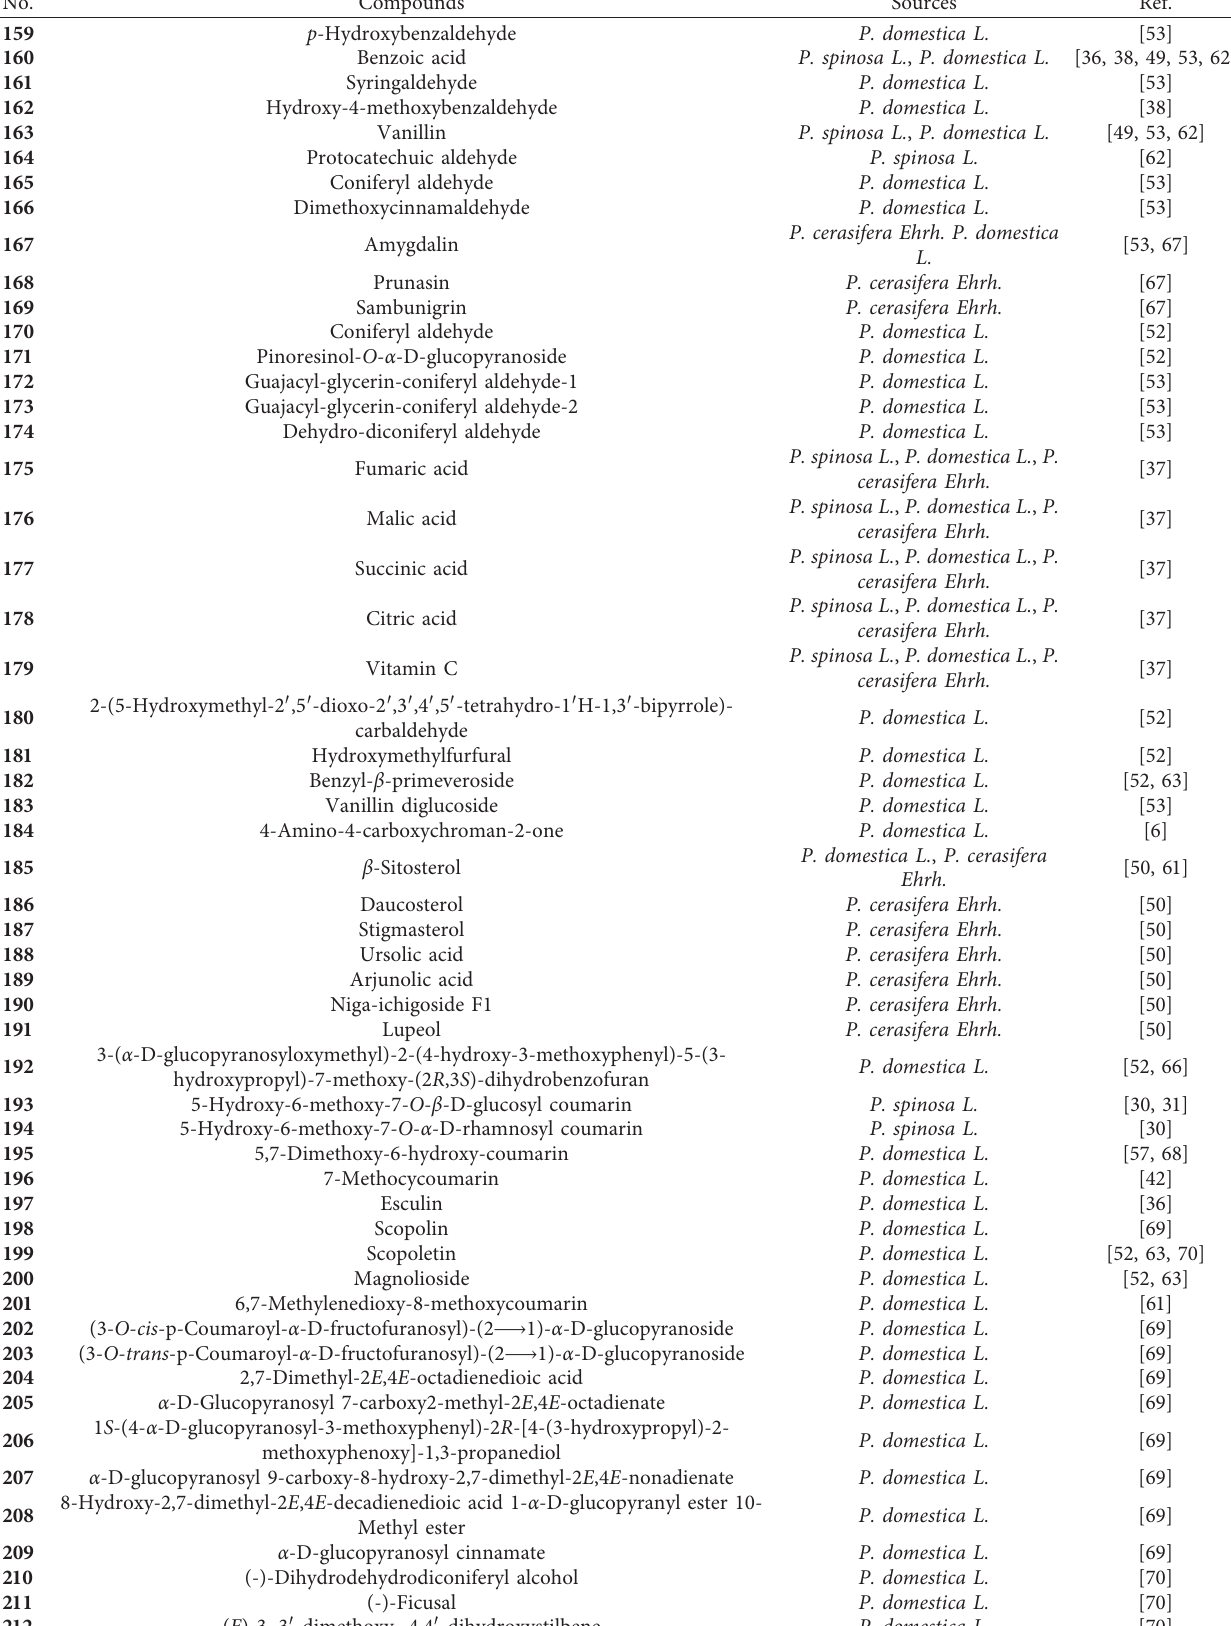
Table 3: Others compounds isolated and identified from different Prunus